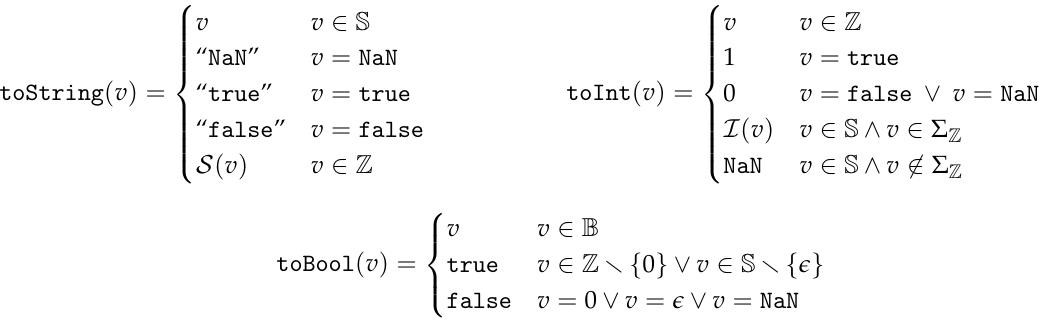
Figure 3. µ JS implicit type conversion